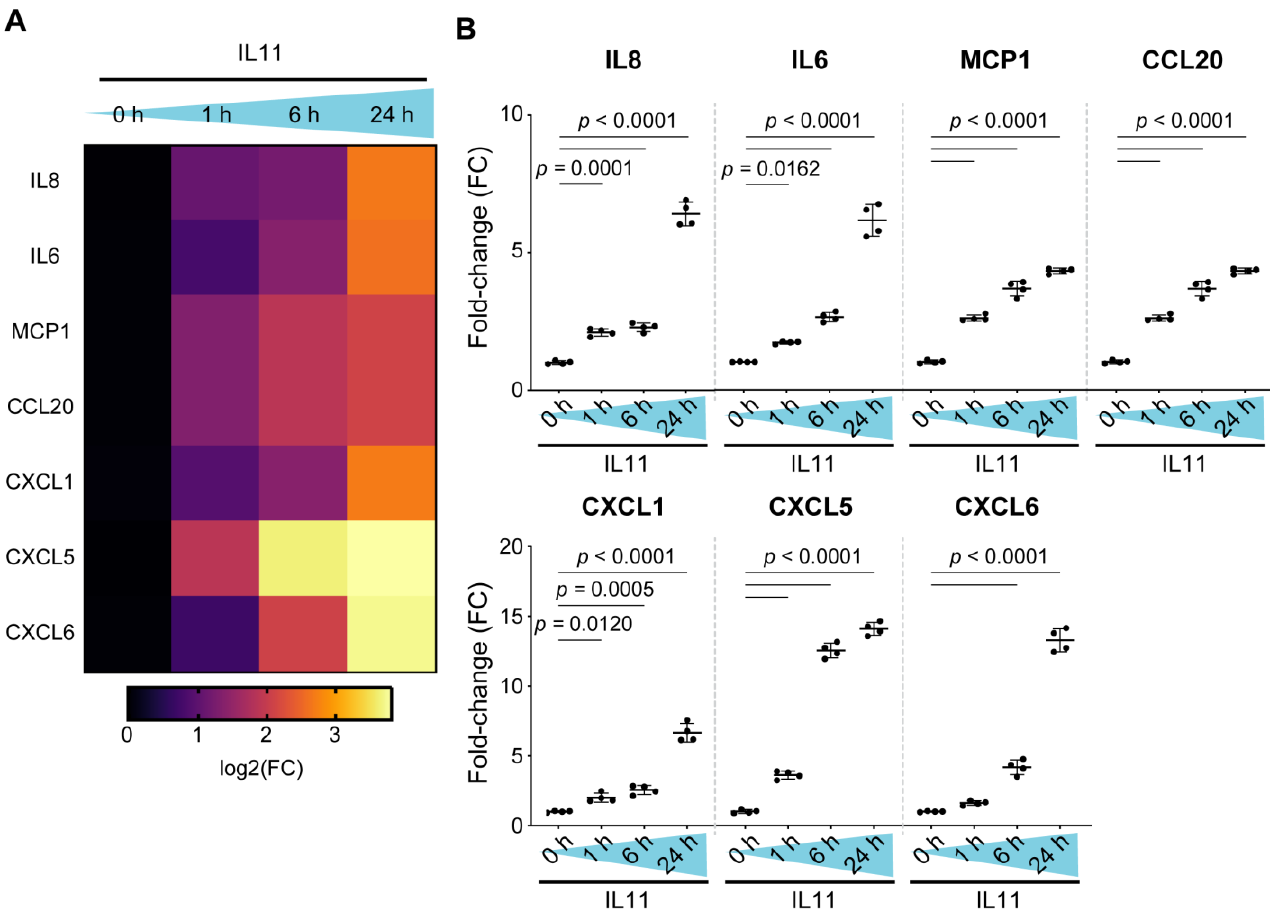
Figure 3. Human kidney fibroblasts stimulated with IL11 secrete a range of pro-inflammatory and chemotactic factors. ( A ) Pro-inflammatory cytokine and chemokine gene expression heatmap. ( B ) Relative levels of IL8, IL6, MCP1, CCL20, CXCL1, CXCL5 and CXCL6 in the supernatant of IL11-stimulated HKF across time points as measured by Olink proximity extension assay. Data are shown as mean ± SD (n = 4 biological replicates); one- way ANOVA with Dunnett’s correction , FC: Fold change.